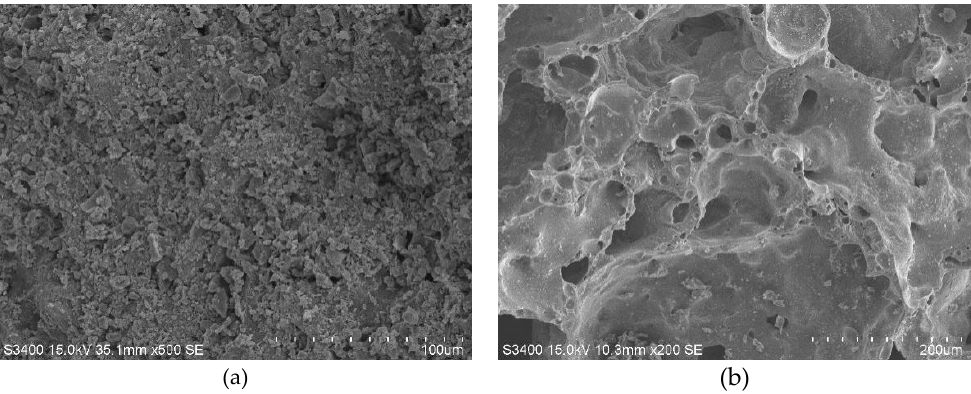
Figure 1. Micro-structures of shale ceramsite: ( a ) Shell, ( b ) Core.